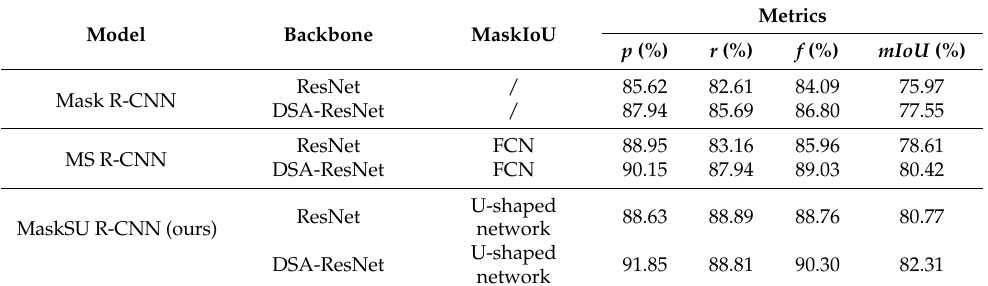
Table 5. Ablation experiments between different instance segmentation